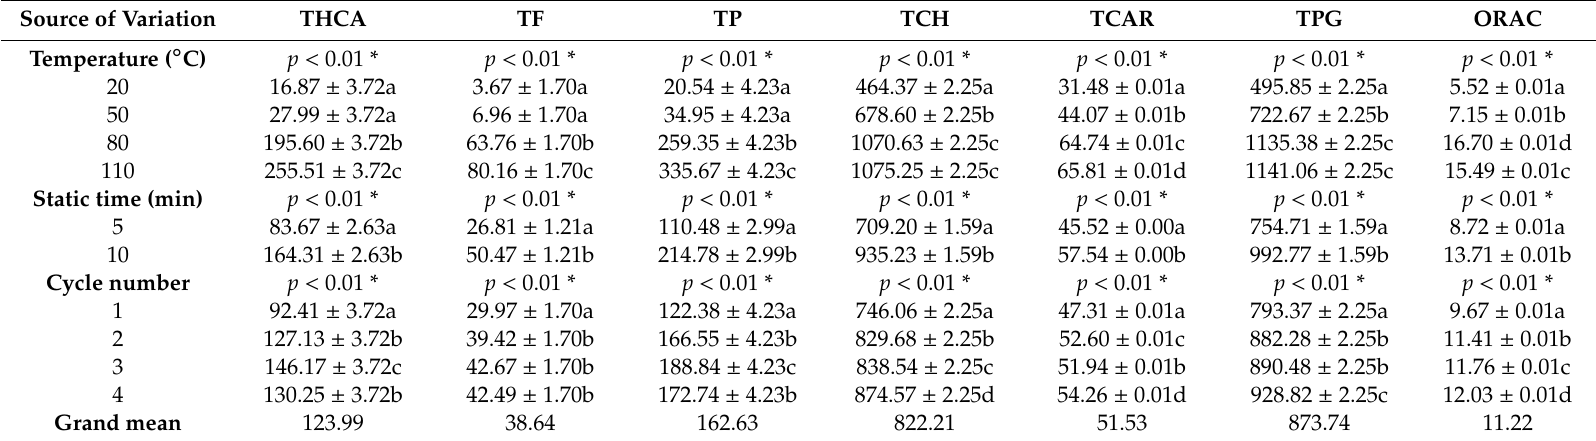
Table 2. The influence of ASE conditions on yield of nettle leaves polyphenols (mg 100 g − 1 dm), pigments (mg 100 g − 1 dm) and ORAC values (mmol TE 100 g − 1 dm). Source of Variation THCA TF TP TCH TCAR TPG ORAC Temperature ( ◦